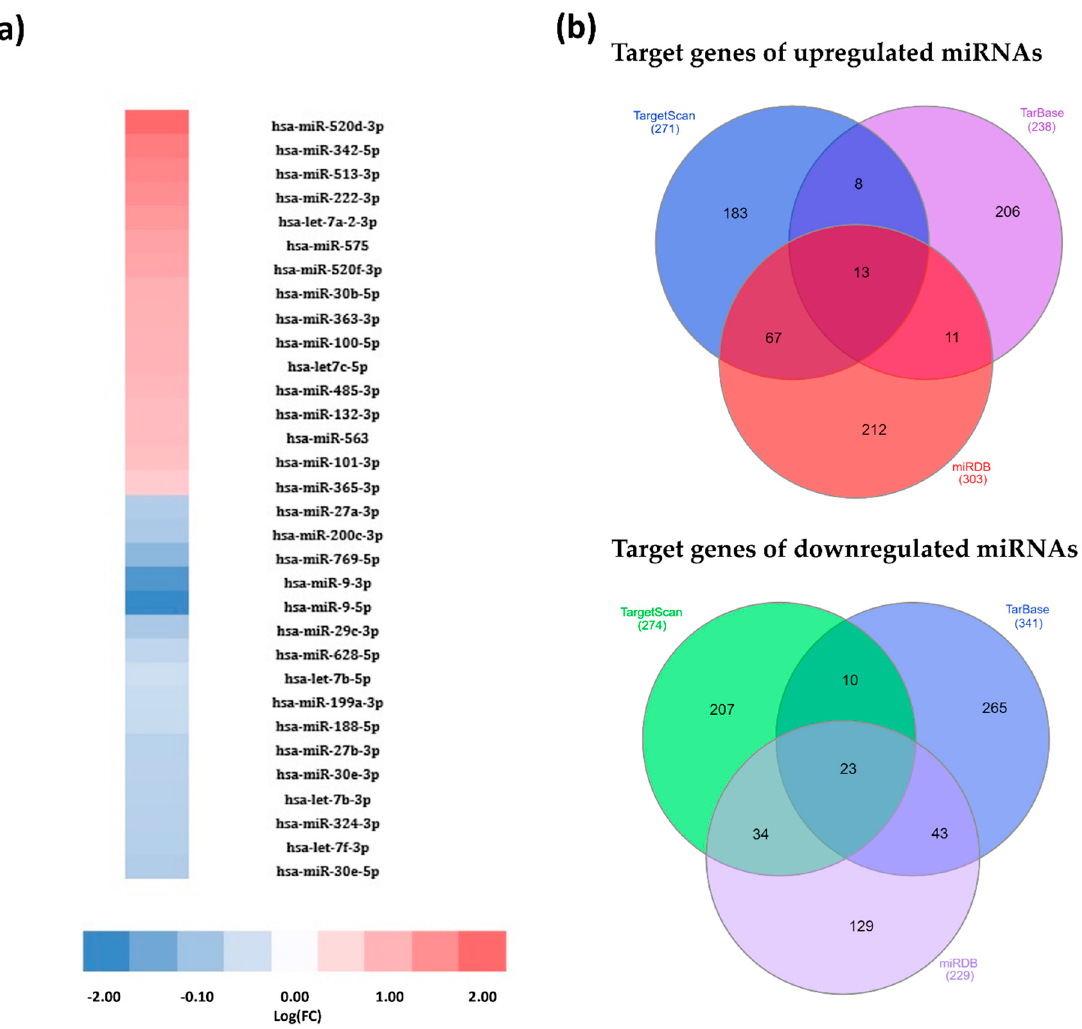
Figure 1. miRNAs differentially expressed by 2-fold or more (with a threshold of significance of p ≤ 0.06) in Ramos cells exposed to HIV-1 AT-2 compared to matched microvesicle cells (control), and alteration of predicted genes. ( a ) Heat map showing differentially expressed miRNAs, data represented as log(FC). ( b ) Venn diagram showing predicted miRNA gene targets identified by three independent bioinformatic tools (TargetScan, Tarbase and miRDB).